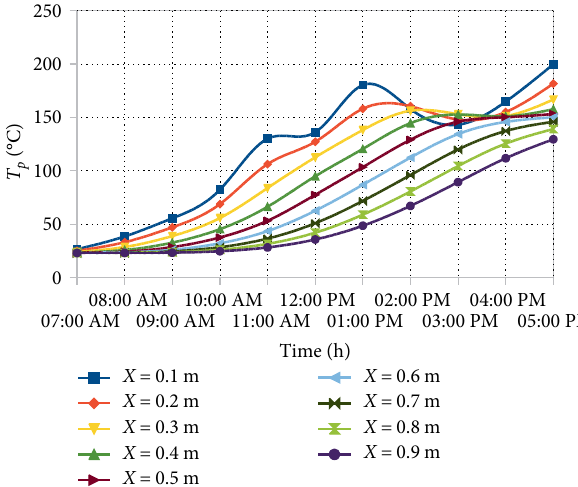
Figure 11: Temperature of thermocline storage charged with respect to charging h from 7 AM to 5 PM for the higher DNI.